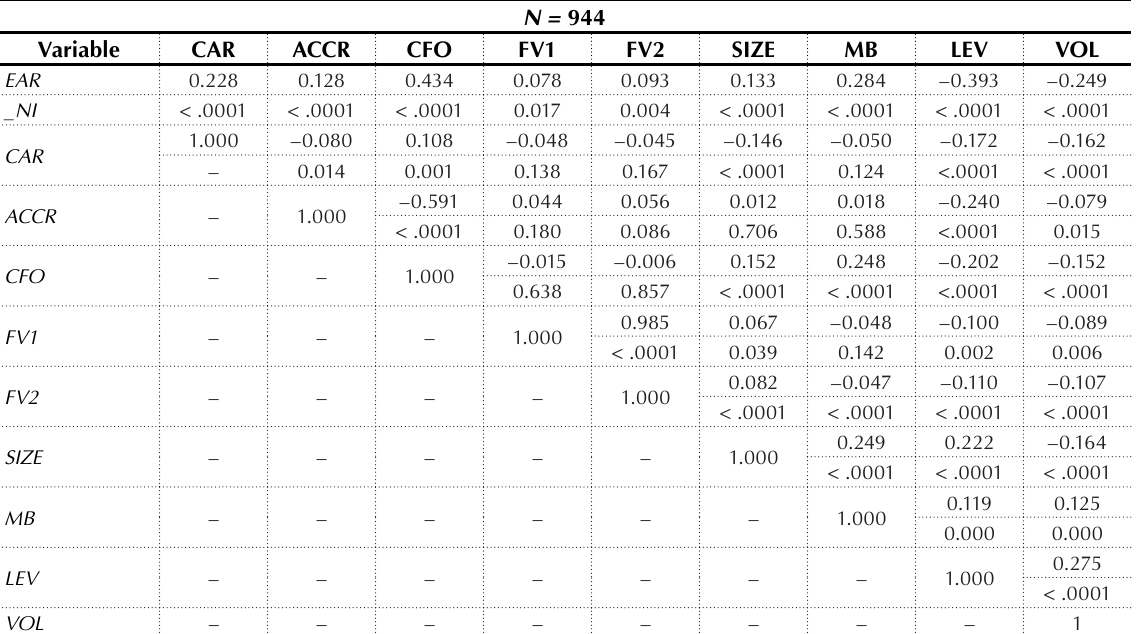
Table 3. Correlation